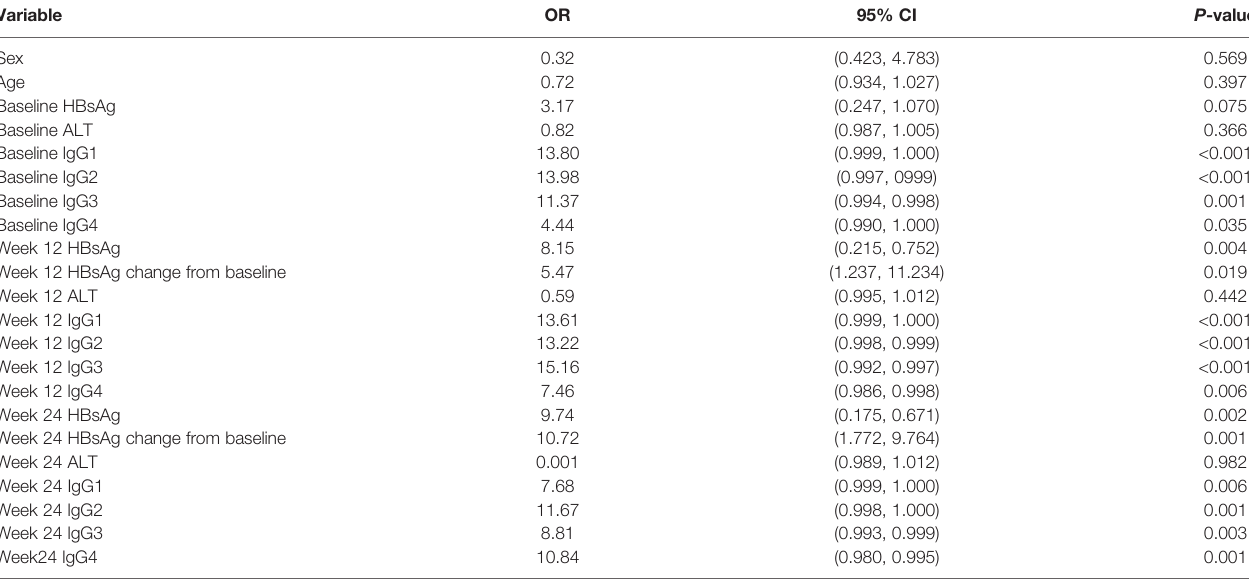
TABLE 2 | Variables at baseline and early treatment associated with HBsAg clearance (univariable analysis).